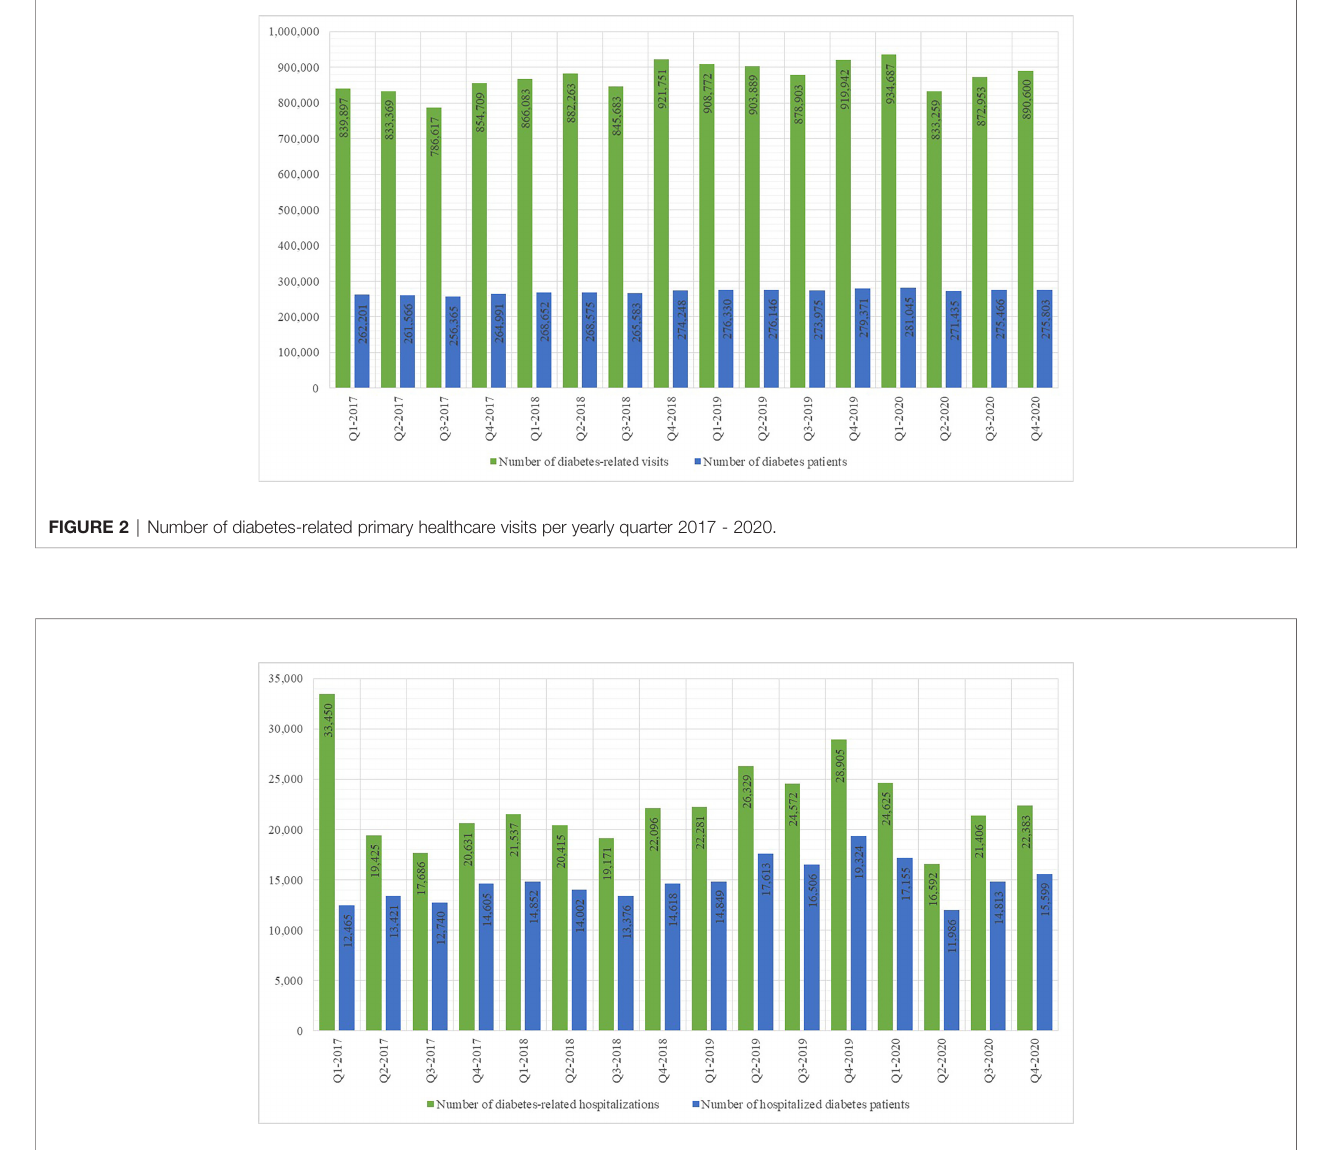
FIGURE 3 | Number of diabetes-related hospitalisations and patients hospitalised for diabetes per yearly quarter 2017 - 2020.